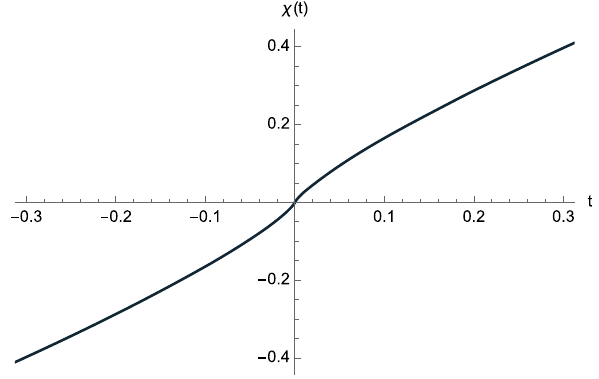
Fig. 3 The function (24) describing early-time null geodesic having θ and ϕ constant. We have chosen R = 1 and t 0 =